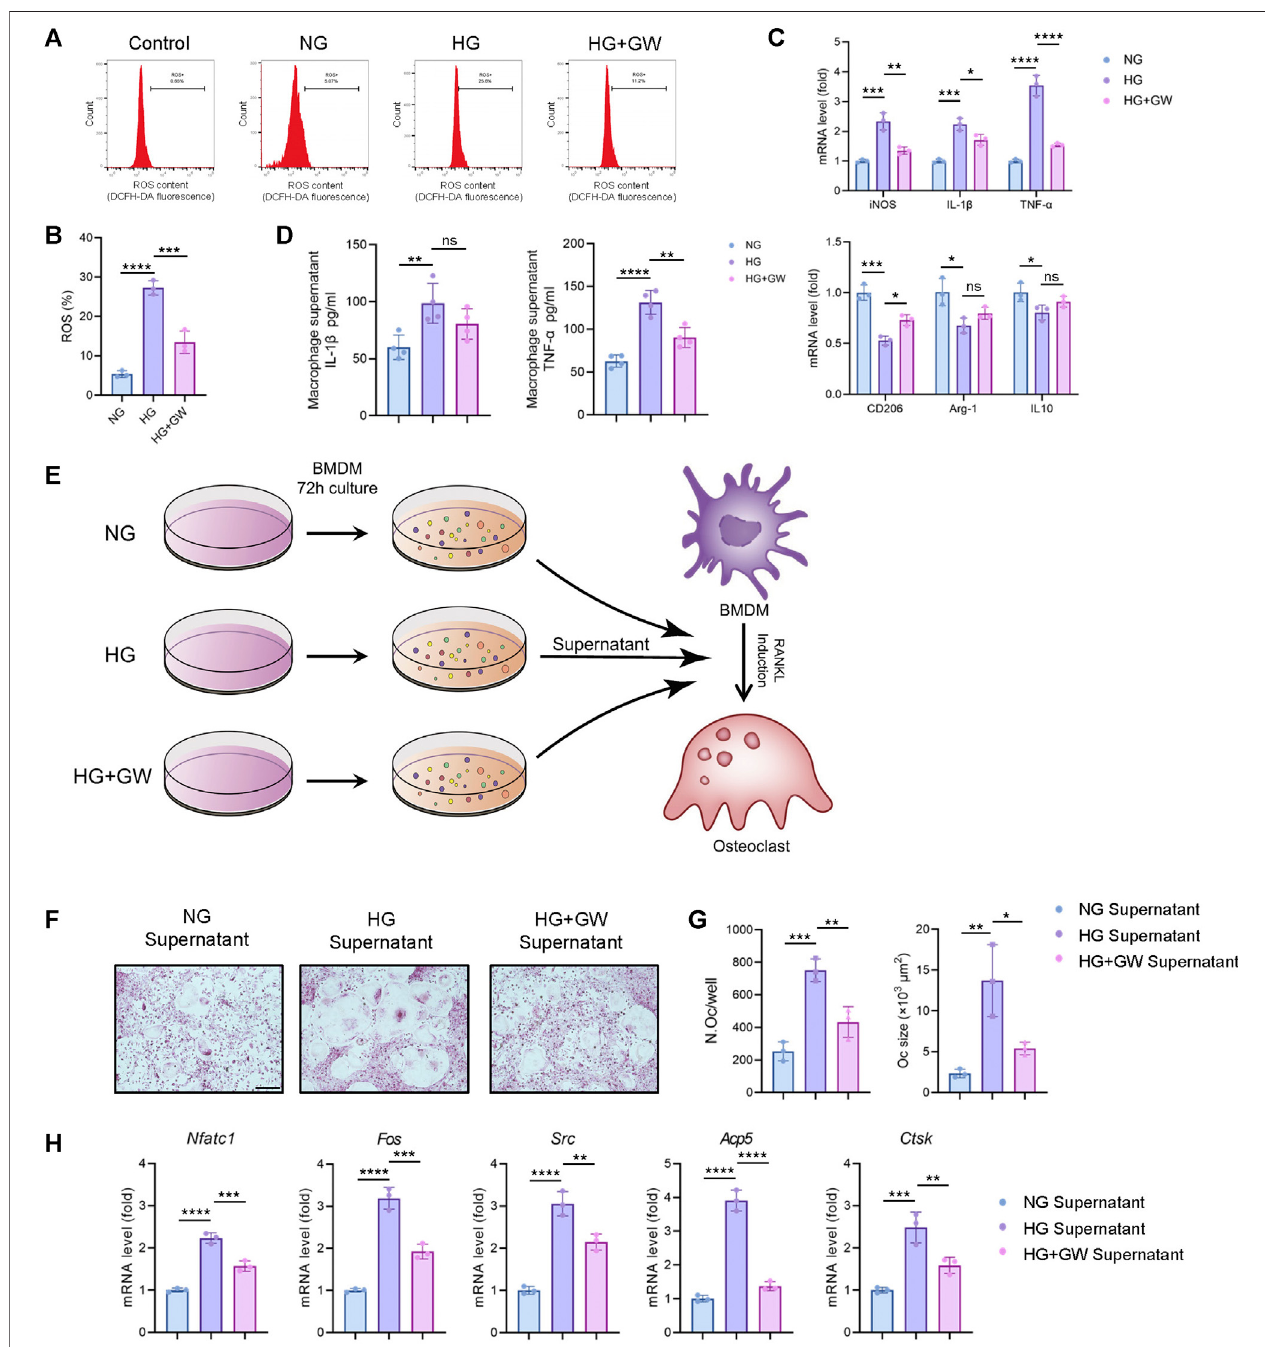
FIGURE 4 | PPAR β / δ agonist alleviates high glucose-induced macrophage in fl ammation and supernatant-mediated osteoclast differentiation. (A) Flow cytometry analysis of ROS levels detected by fl uorescent probe in different groups. (B) Statistics for the ROS levels. (C) RT-PCR results regarding the expression levels of macrophage polarization-related genes in different groups. (D) Expression level ofIL-1 β and TNF- α detected by ELISA. (E) Schematic illustration of experimental design for regulating osteoclast differentiation through macrophage culture supernatant. (F) Representative images of TRAP staining for osteoclast differentiation in different groups. Scale bar (cid:2) 100 μ m. (G) Statistics for the number and size of osteoclasts. (H) RT-PCR results of the expressions of the osteoclastogenesis-related genes in different groups. Data were expressed as mean ± SD. The p values were calculated by one-way ANOVA. (ns, not statistically signi fi cant, * p < 0.05, ** p < 0.01, *** p < 0.001, **** p < 0.0001).